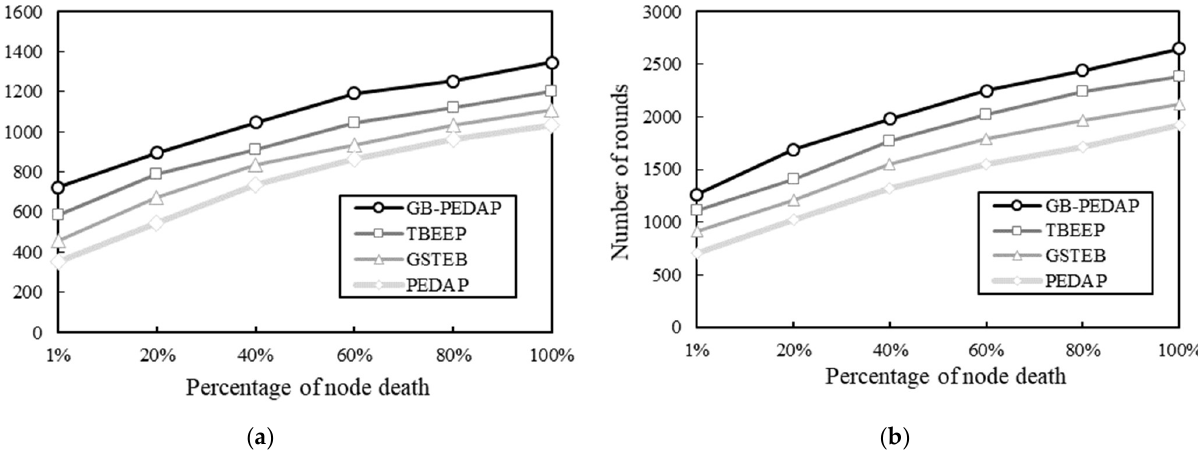
Figure 3. Number of rounds under different percentages of node death: ( a ) initial energy is 0.25 J; ( b ) initial energy is 0.5 J.